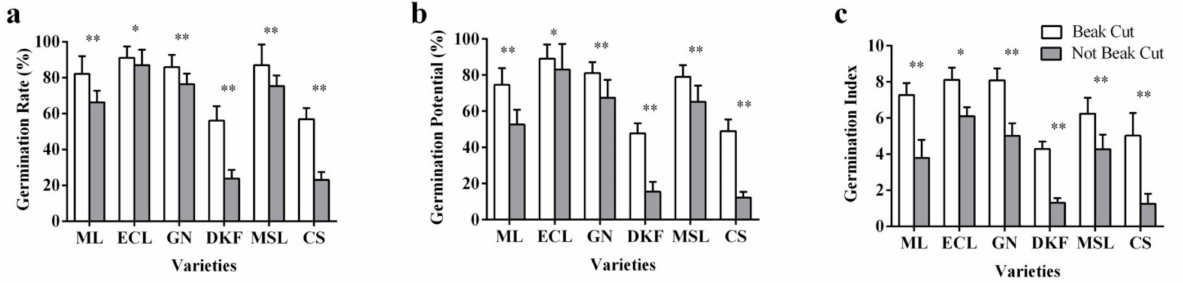
Figure 3. Effect of beak cutting treatment on seed germination characteristics of six tested varieties: ( a ) influence of beak cutting on seed germination rate of tested varieties, ( b ) influence of beak cutting on the germination potential of the tested varieties, and ( c ) influence of beak cutting on the germination index of the tested varieties. Data in this figure were tested by Student’s t test; * p < 0.05 and ** p < 0.01 represent significant differences between treatments, and ns indicates not sig- nificant. ML, ECL, GN, DKF, MSL, and CS represent varieties of Meili, Ecolly, Garanior, Dunkelfelder,